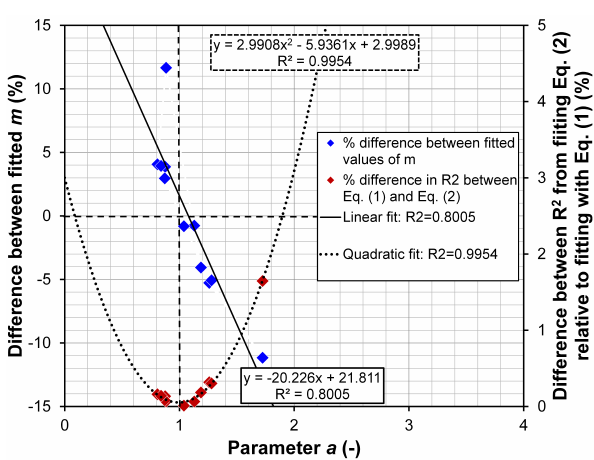
Figure 2. Cementation exponent derived from fitting Archie’s (1942) law (Eq. 1, solid blue symbols) and the Win- sauer et al. (1952) variant of Archie’s law (Eq. 2, solid orange symbols) as a function of the cementation exponent derived as the mean of the cementation exponents calculated from data from individual core plugs using Eq. (3), which is based on Archie’s original law. The dashed line shows a 1:1 relationship. Each symbol represents data from one of the 11 reservoirs analysed in Fig. 1.